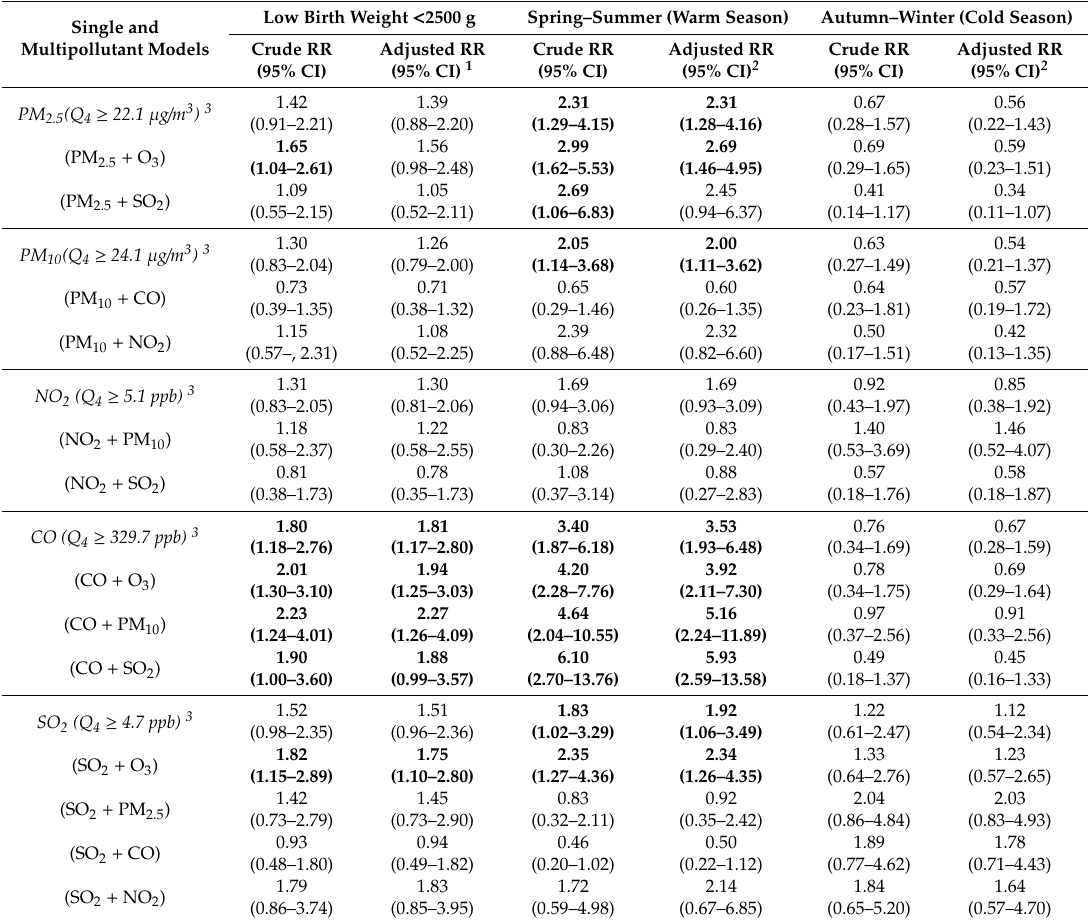
Table A3. The e ff ects of air pollution exposure during entire pregnancy on low birth weight less than 2500 g (N = 2517), The Espoo Cohort Study,